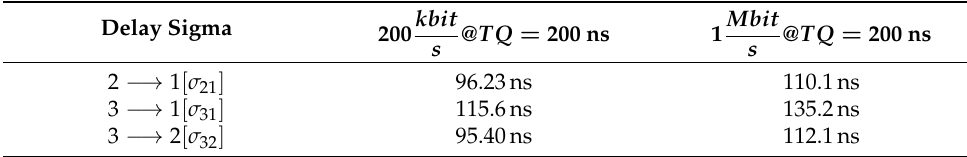
Table 3. Standard deviations of three delays with different bit